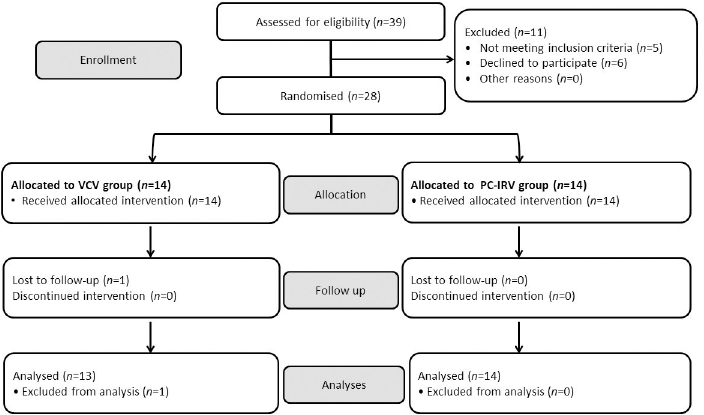
Fig 2. CONSORT diagram of patient recruitment for the comparison of volume-controlled ventilation and pressure-controlled inverse ratio ventilation.